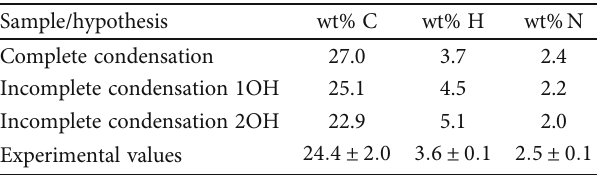
Figure 5: Infrared spectrum of the adsorbent. Table 2: C, H, and N contents of the Schi ff base-modi fi ed aerogel- like